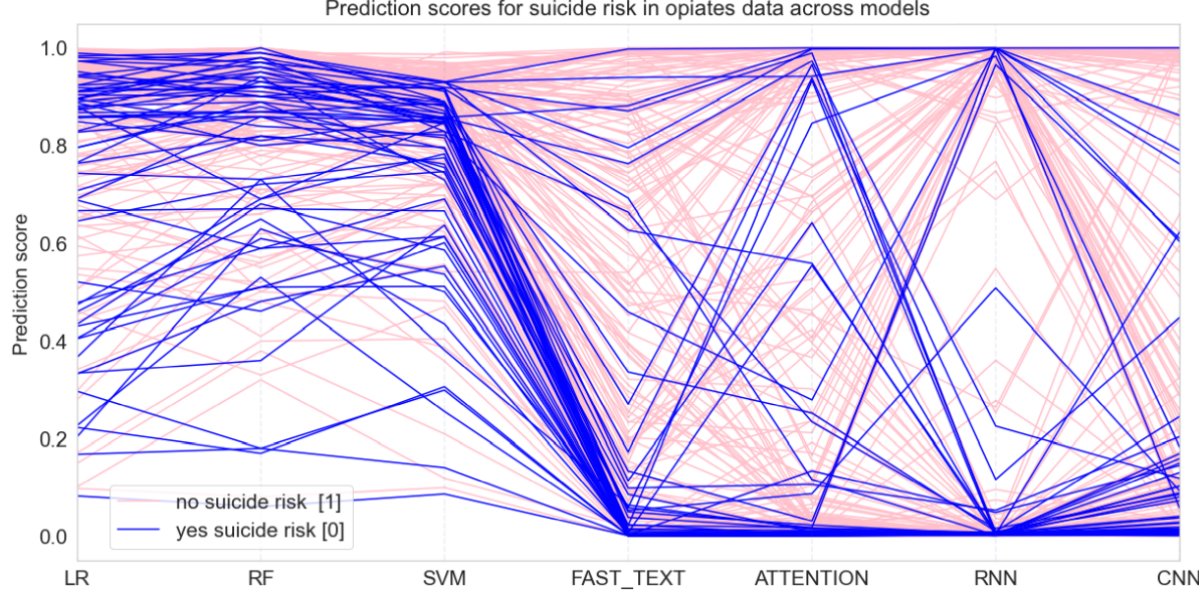
Figure 4. Model predictions for individual posts represented as a line. A prediction closer to 1 indicates no predicted suicidal language and a prediction closer to 0 indicates yes predicted suicidal language. Individual posts are color coded by their MTURK label. ATTENTION: attention-based bidirectional recurrent neural network; CNN: convolutional neural network; FAST_TEXT: FastText; LR: logistic regression: RF: random forest; RNN: recurrent neural network; SVM: support vector